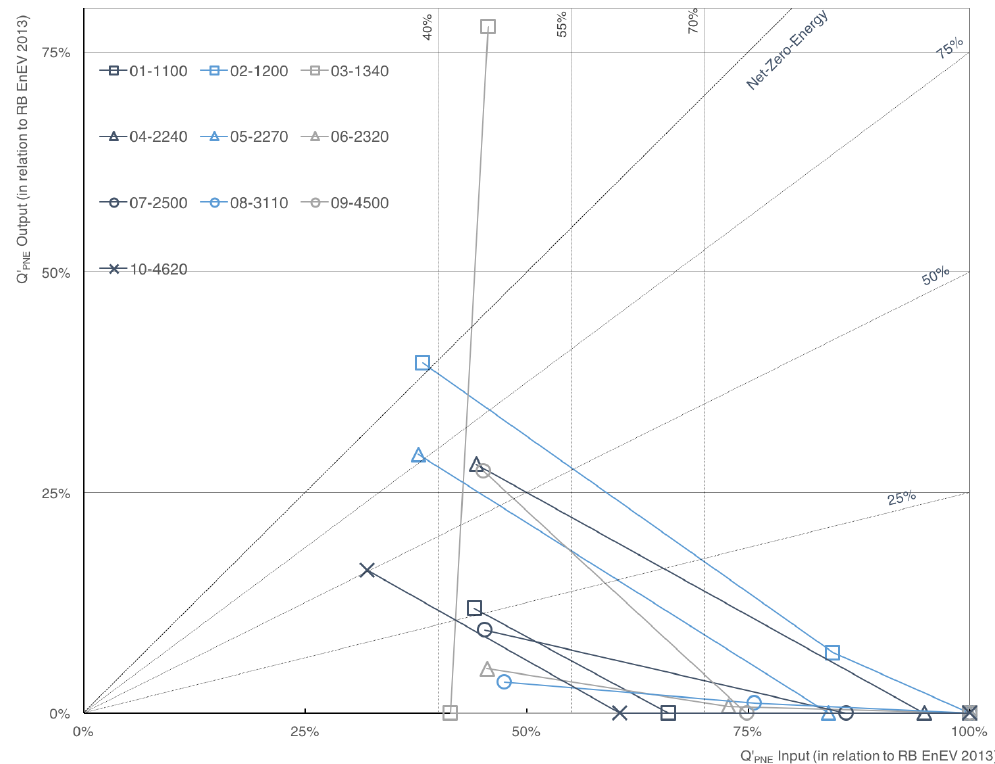
Figure 6. The result of all case studies—input-output balance (Q’ PNE (kWh/m 2 a)) as a percentage of the reference building (RB 2013 = 100%) in the energy standard’s reference building according to EnEV (right data point), standard case study (middle data point), and standard nZEB 2021 (left data point).